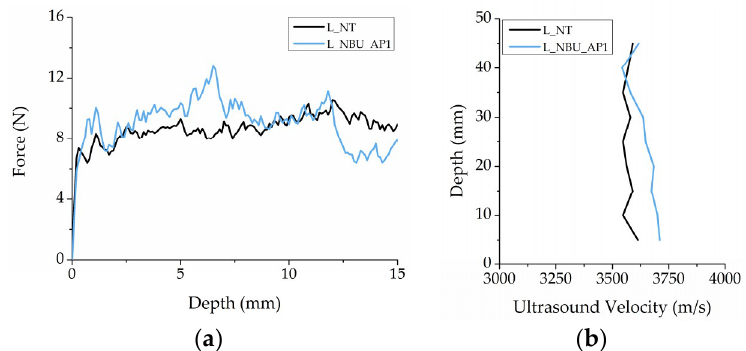
Figure 8. Lecce stone treated with NBU applied by brushing till saturation AP1 (L_NBU_AP1): ( a ) drilling resistance and ( b ) UPV profile. NT: Untreated stone.